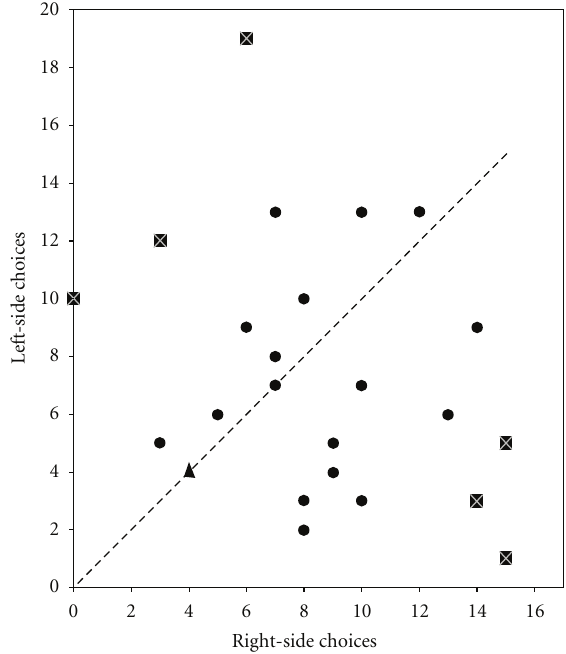
Figure 2: The number of choices for the feeder on the left or right side made by individuals that made at least eight choices during a trial. Each symbol represents an individual. The dotted line represents choices of 1: 1. The triangle represents two overlapping individuals that chose the right and left equally (4 times each); the squares containing an X represent individuals that showed a significant bias for one side ( P < .